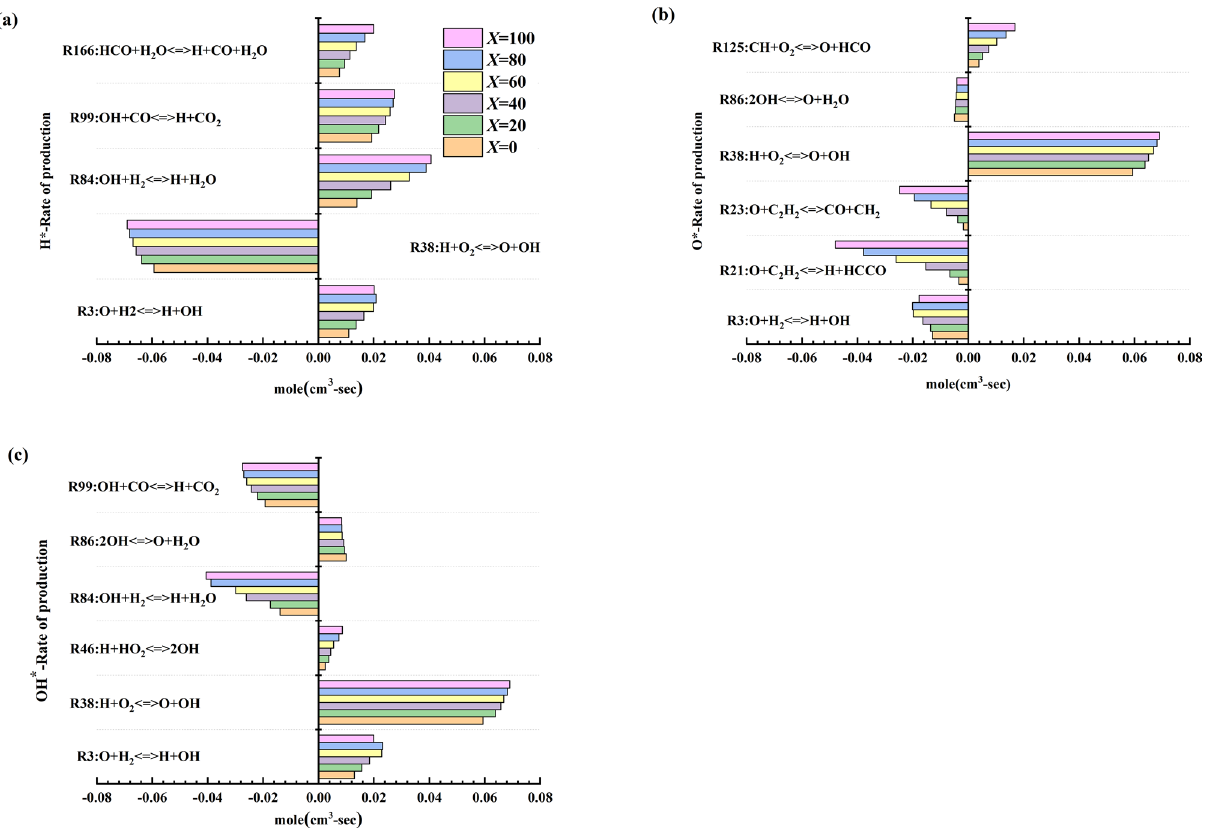
Figure 9. Rates of production and consumption of free radicals [( a ) H*, ( b ) O*, ( c )